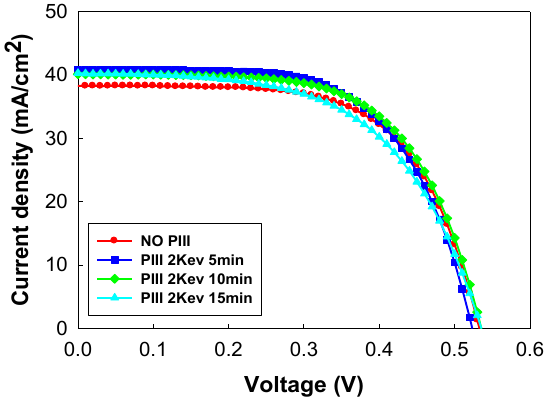
Figure 9. The I-V characteristic curve of without PIII, PIII 2 KeV 5 min, PIII 2 KeV 10 min, and PIII 2 KeV 15 min samples.